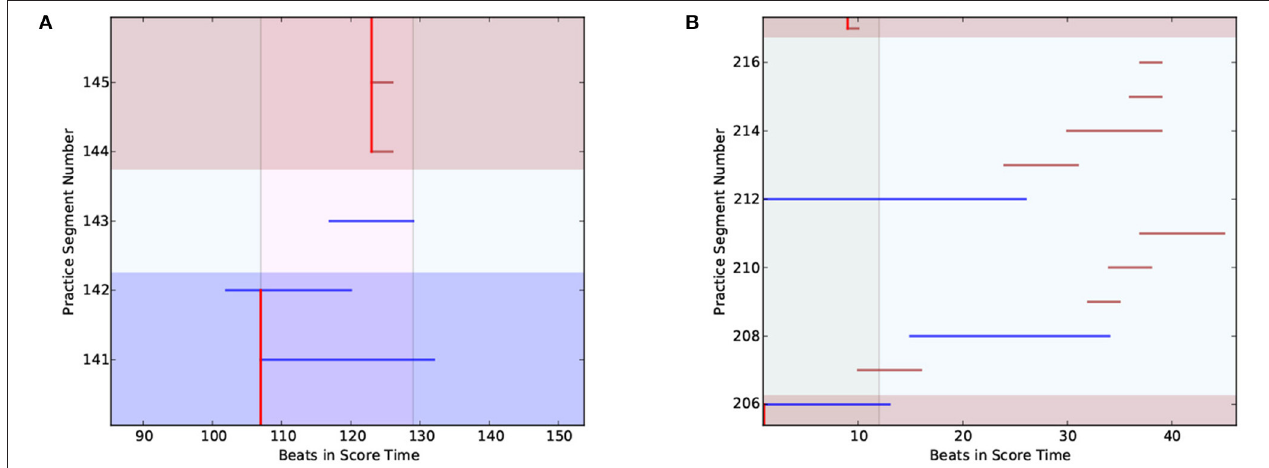
FIGURE 15 | Examples of the review and explore practice pattern. (A) RE pattern (segments 142-143) from player I-2. (B) RE pattern (segments 206-216) from player N-2.